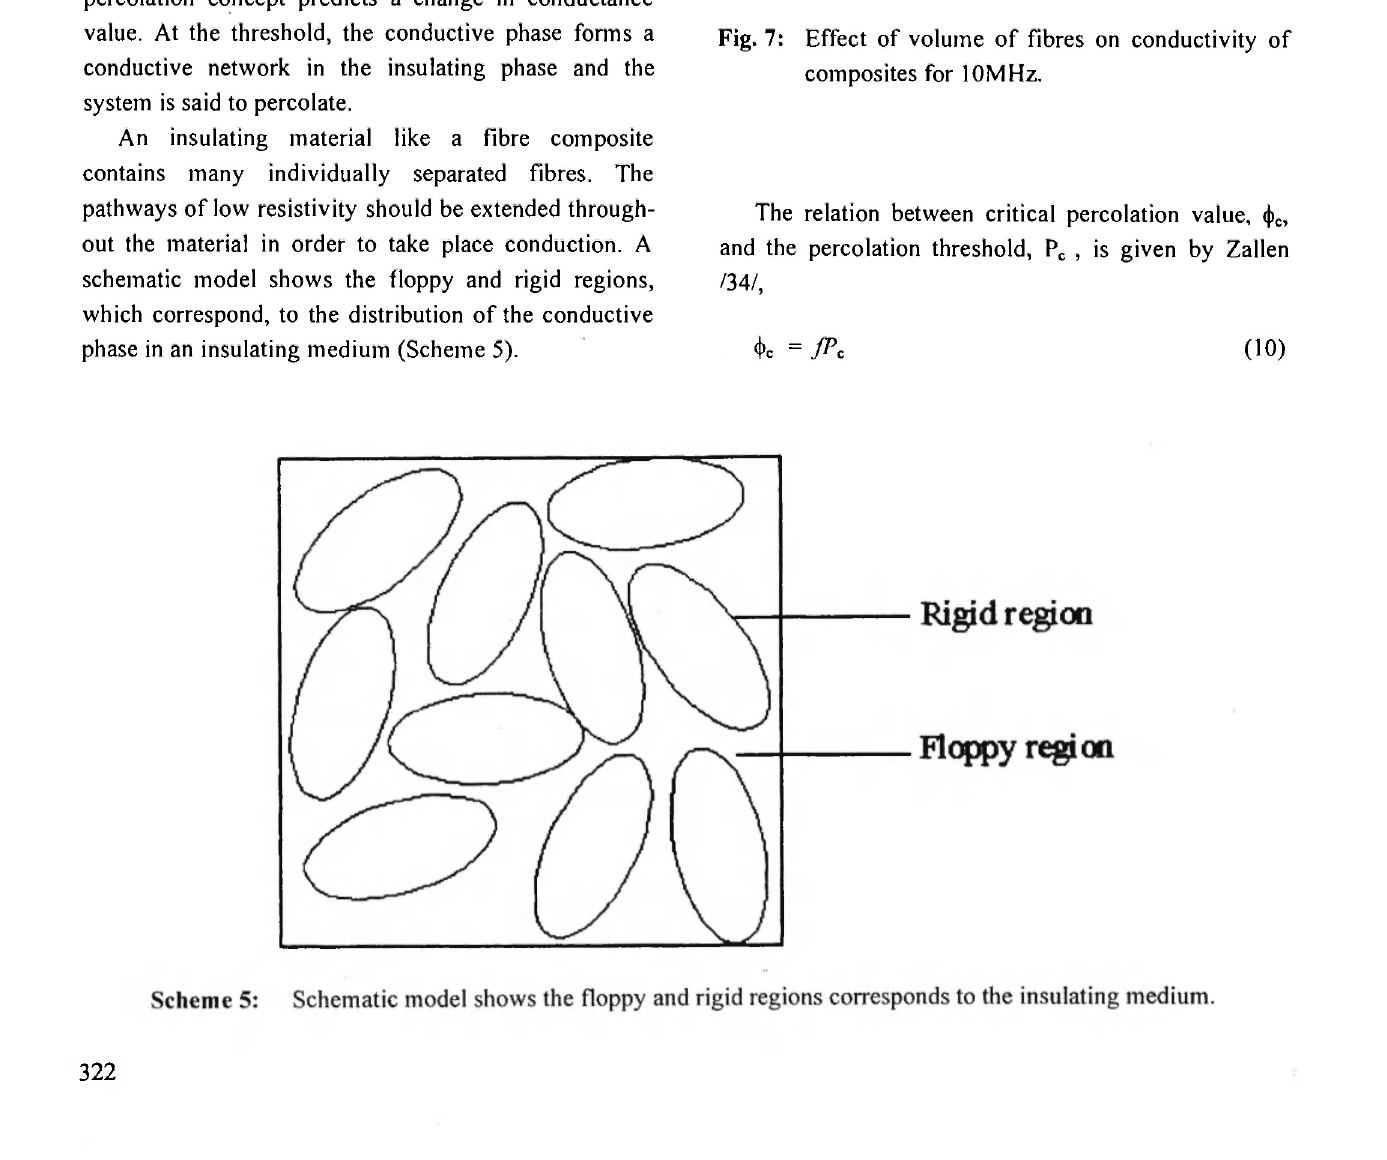
Fig. 7: Effect of volume of fibres on conductivity of composites for